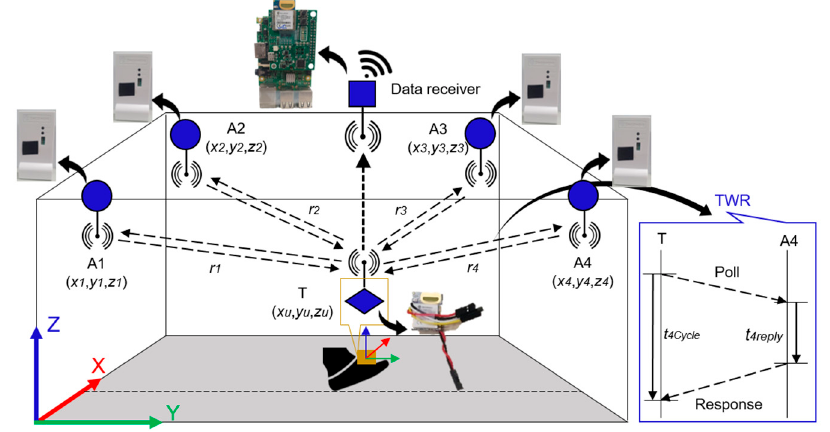
Figure 3. Infrastructure layout and concept of UWB positioning system.